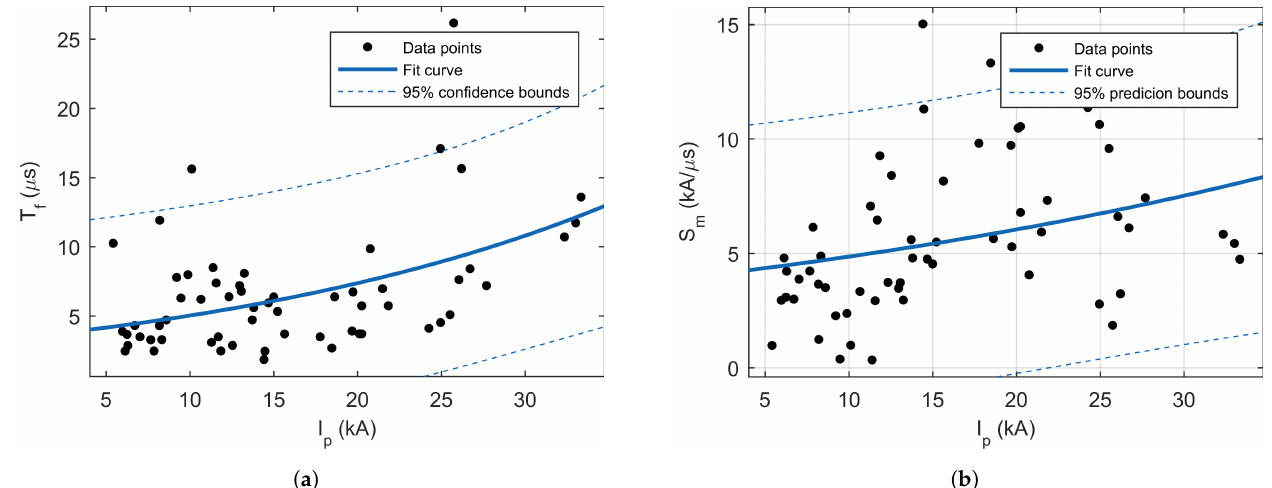
Figure 9. Scatterplots of the relations: ( a ) between first negative peak current and current front time, and ( b ) between first negative peak current and maximum steepness.